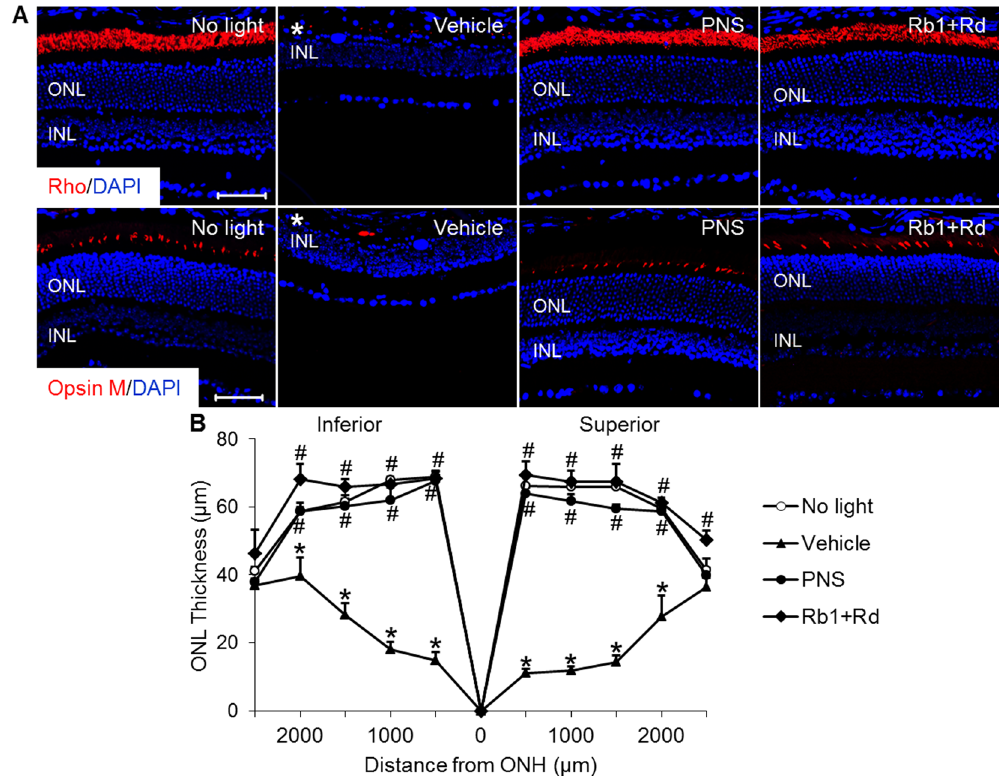
Figure 2. Treatment of PNS or combination of Rb1 and Rd prevented the loss of rods and cones in bright light-exposed mice. Dark-adapted BALB/c mice were pretreated with saline vehicle (Vehicle), PNS at 200 mg/ kg bw (PNS) or combination of Rb1 (65 mg/kg bw) and Rd (22.5 mg/kg bw) 30 min before bright light exposure. ( A ) Eyes were enucleated from vehicle-treated mice unexposed to bright light (No light) and the bright light- exposed mice with the indicated treatment 7 d after illumination and paraffin sections were made for IHC assessment of the retinal expression of Rho and opsin M (in red). Counterstaining with DAPI (in blue) was also performed. ( B ) ONL thickness across the retina was measured in DAPI-stained paraffin sections. Asterisk indicated diminished ONL. INL, inner nuclear layer; ONH, optic nerve head; ONL, outer nuclear layer. Scale bar: 50 μ m. The data were expressed as the mean ± S.E.M (n = 4–8 per group). * Compared to that from No light, p < 0.05; # compared to that from Vehicle, p <